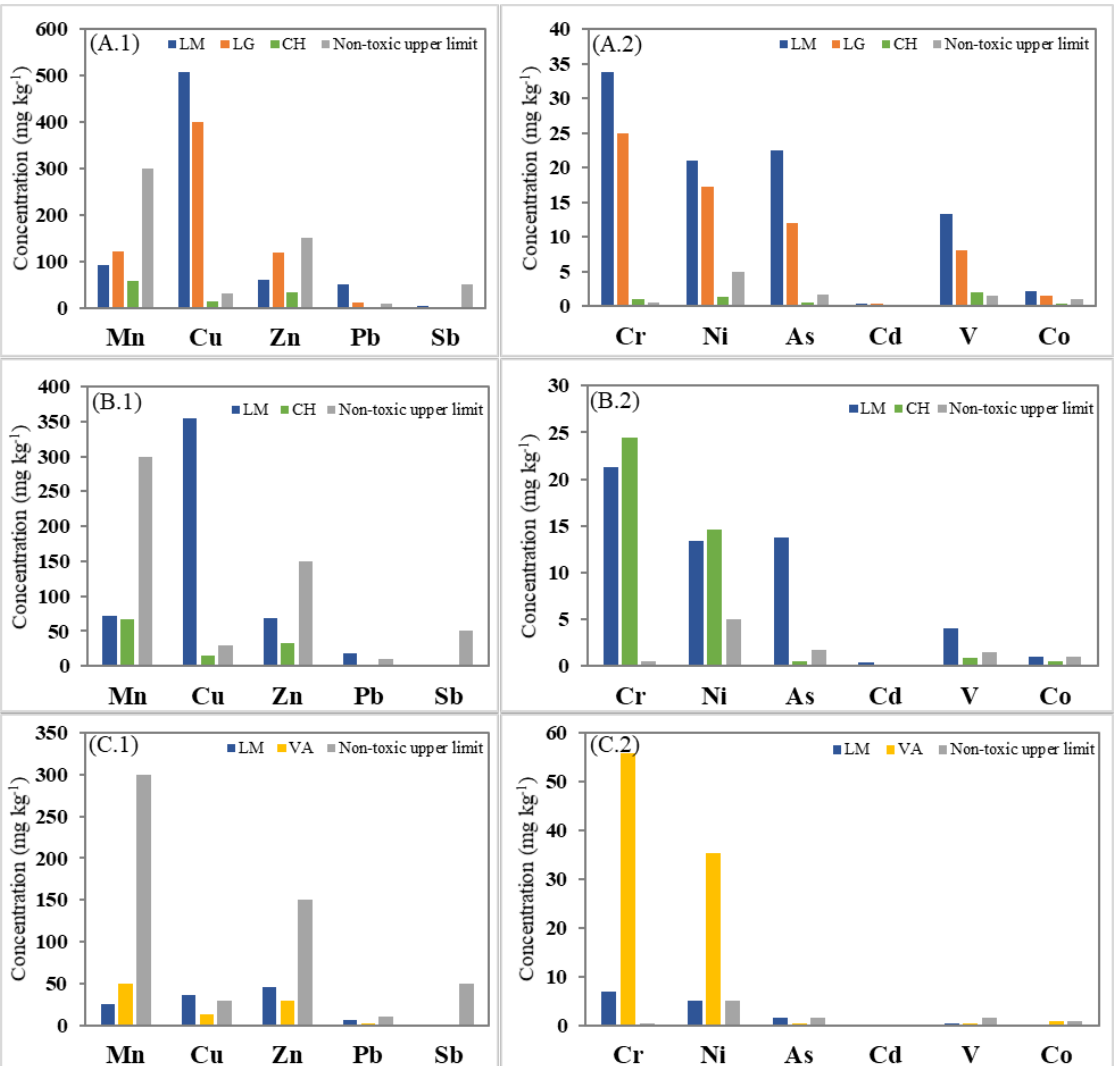
Figure 2. Mean trace element (TE) concentration (mg kg −1 ) at each sampling location according to the plant species: O. picensis ’ TEs in major ( A.1 ) and in minor ( A.2 ) concentrations; S. velutina ’s TEs in major ( B.1 ) and in minor ( B.2 ) concentrations; and A. subfusiformis ’ TEs in major ( C.1 ) and in minor ( C.2 ) concentrations.